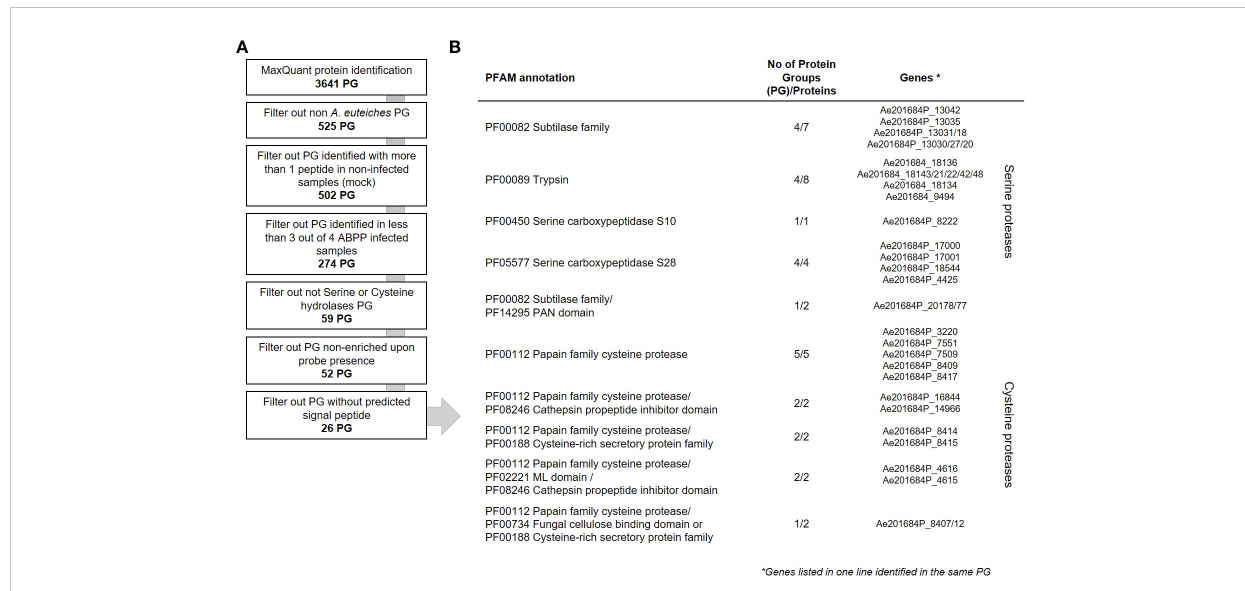
FIGURE 3 Data analysis work fl ow of secreted proteases from A. euteiches. (A) Downstream analysis of the MaxQuant assigned Protein Groups (PG). The number of PGs on each step is indicated in bold. (B) List of the mass spectrometry identi fi ed extracellular serine and cysteine proteases from A. euteiches present in apoplastic fl uid of pea, 15 days post infection. Gene IDs according to AphanoDB nomenclature. Note that the sequences given in each line of the table belong to the same PG. See Supplementary Tables S6 – S8 for complete